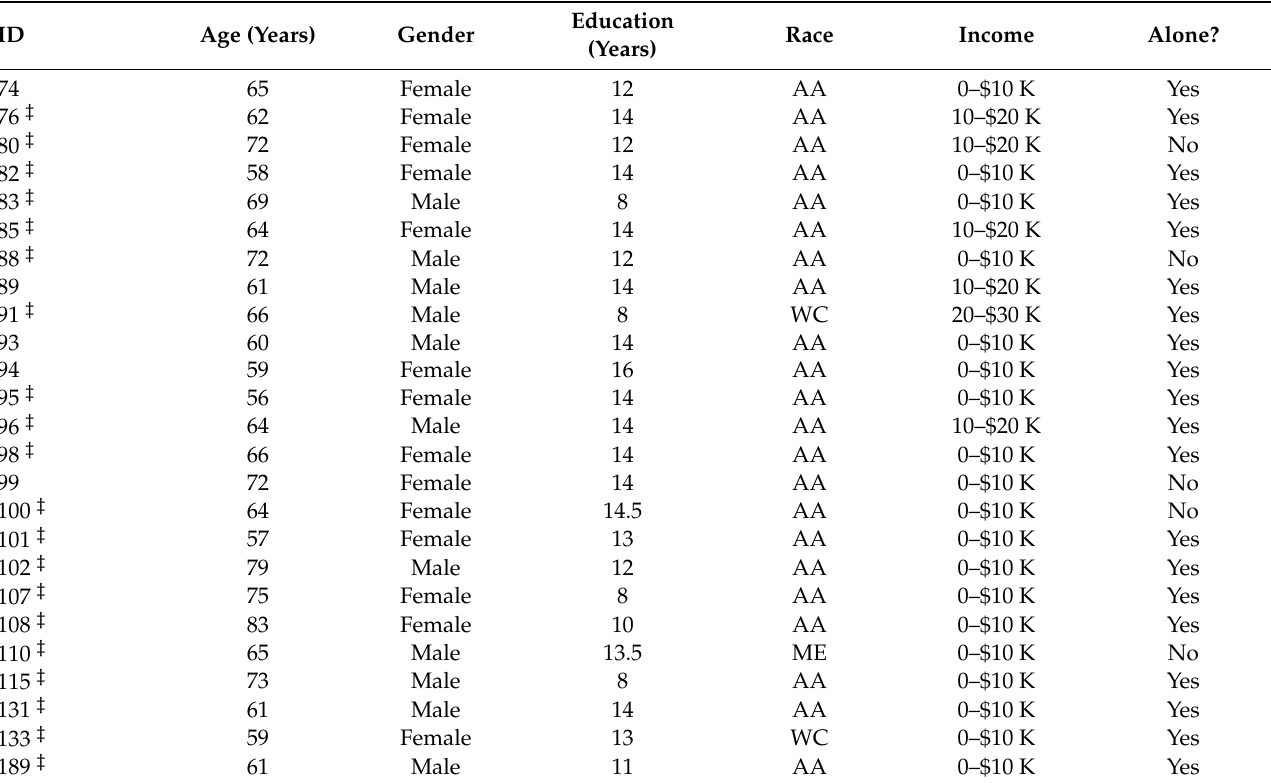
Table 2. Participants’ demographics (PID = Participant Identifier, ‡ = Prescribed Medications, AA = African American, WC = White Caucasian, ME = Multi-Ethnic, and Alone = Living